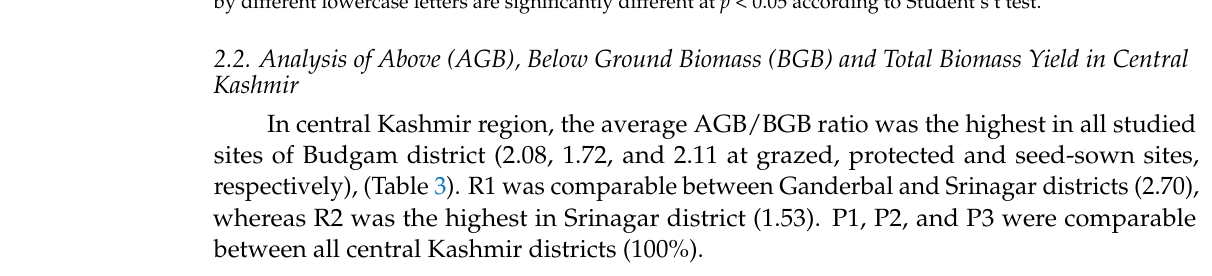
Table 3. Comparison between central Kashmir districts in terms of biomass